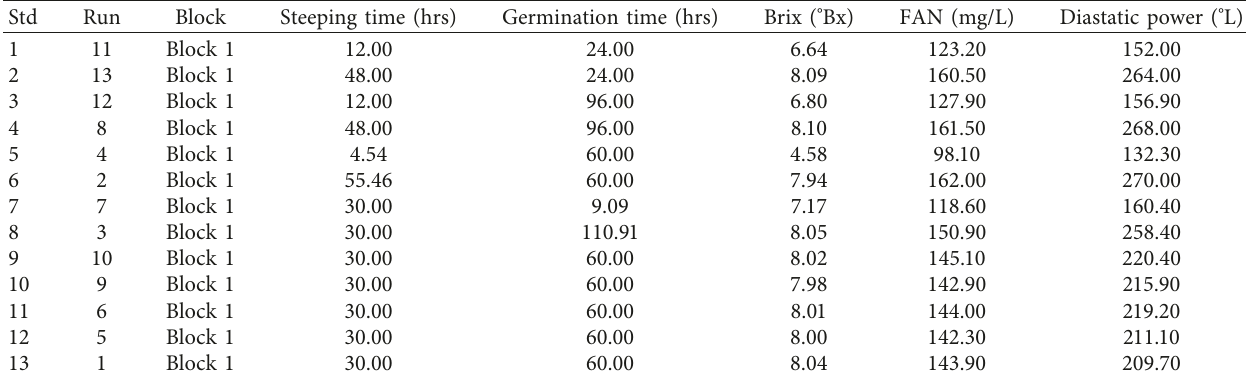
Table 3: A central composite design (CCD) for barley malting using response surface